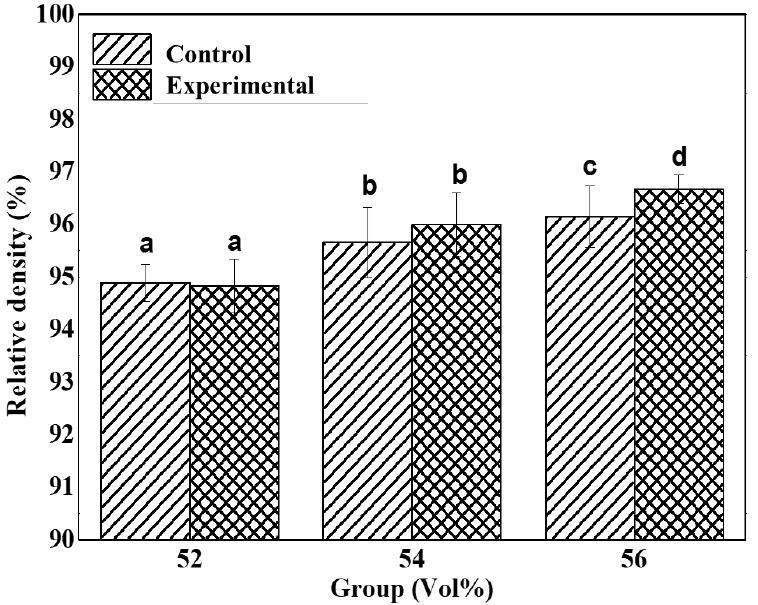
Figure 6. Comparison of relative density between control and experimental groups; different letters represent significant differences ( p < 0.05).